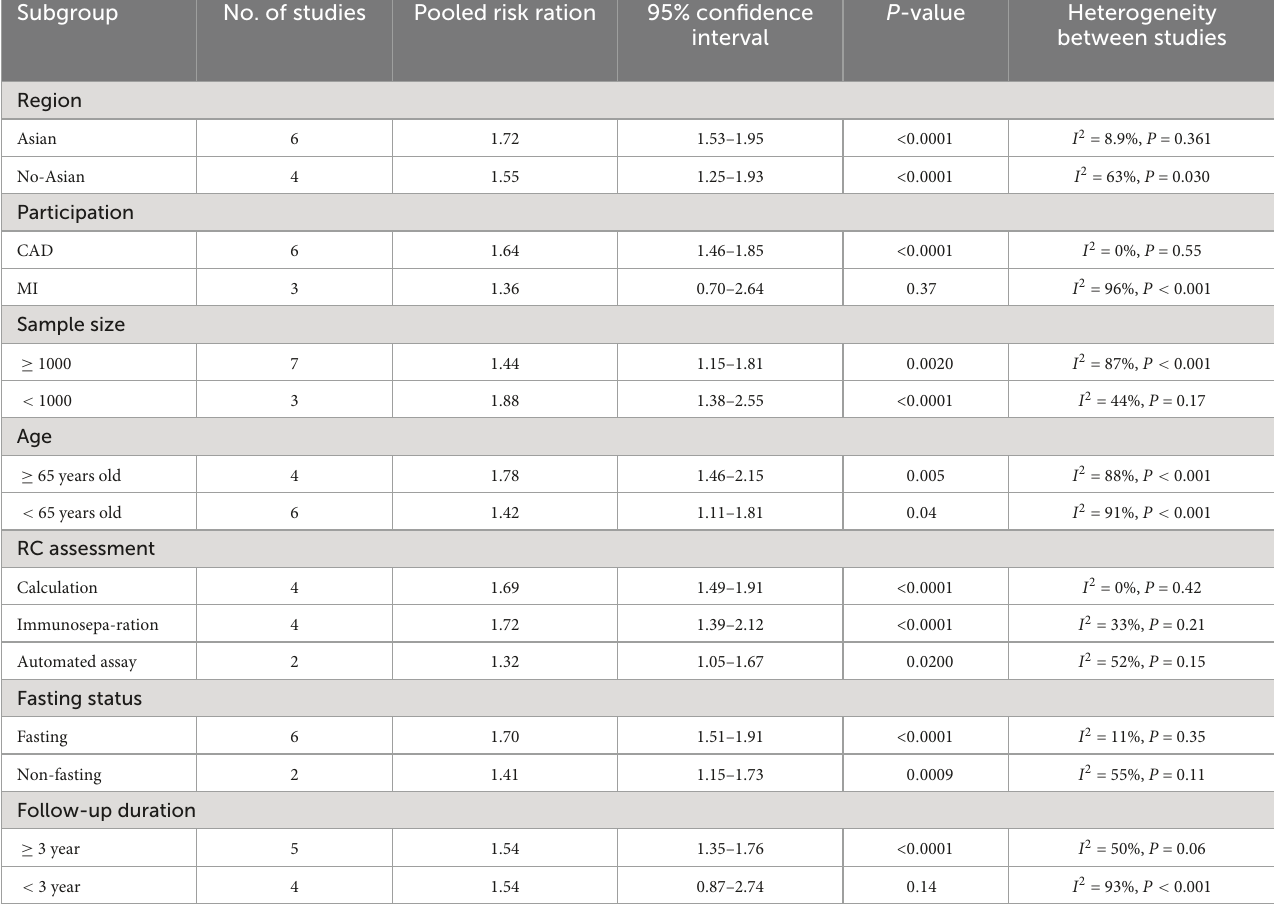
TABLE 2 Subgroup analysis on composite endpoint